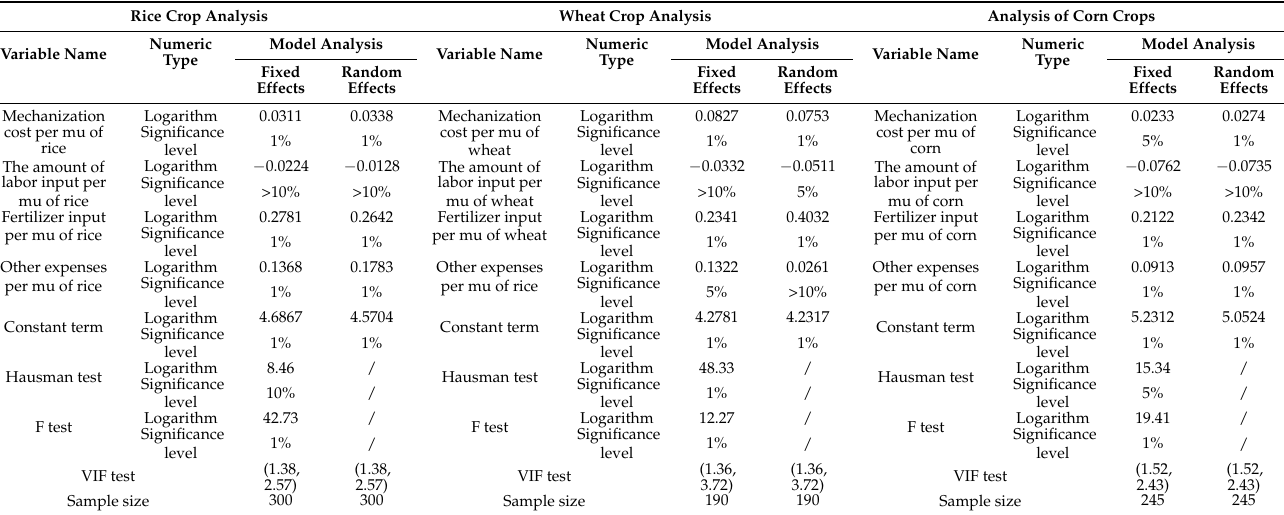
Table 5. Analysis of crop yield per unit